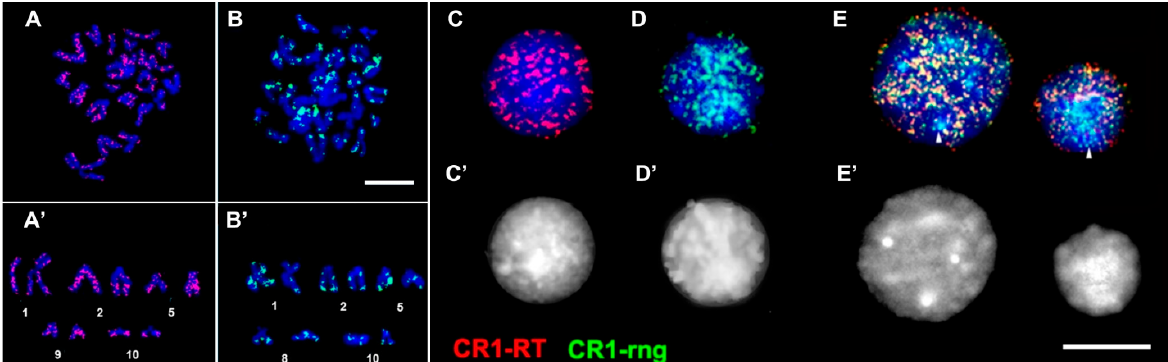
Figure 6. FISH mapping of CR1-4_7 (RT, red, A ) and CR1-rng (green, B ) probes on DAPI-stained fluke metaphase chromosomes. ( A’ , B’ ) show chromosomes with the most typical signal patterns. The same indicated probes were mapped onto DAPI-stained fluke nuclei ( C , D ). ( E ) Co-hybridisation of the same probes; ( C’ – E’ )—same nuclei, shown in greyscale to make the condensed chromatin visible (bright). Scale bar—10 μ m.